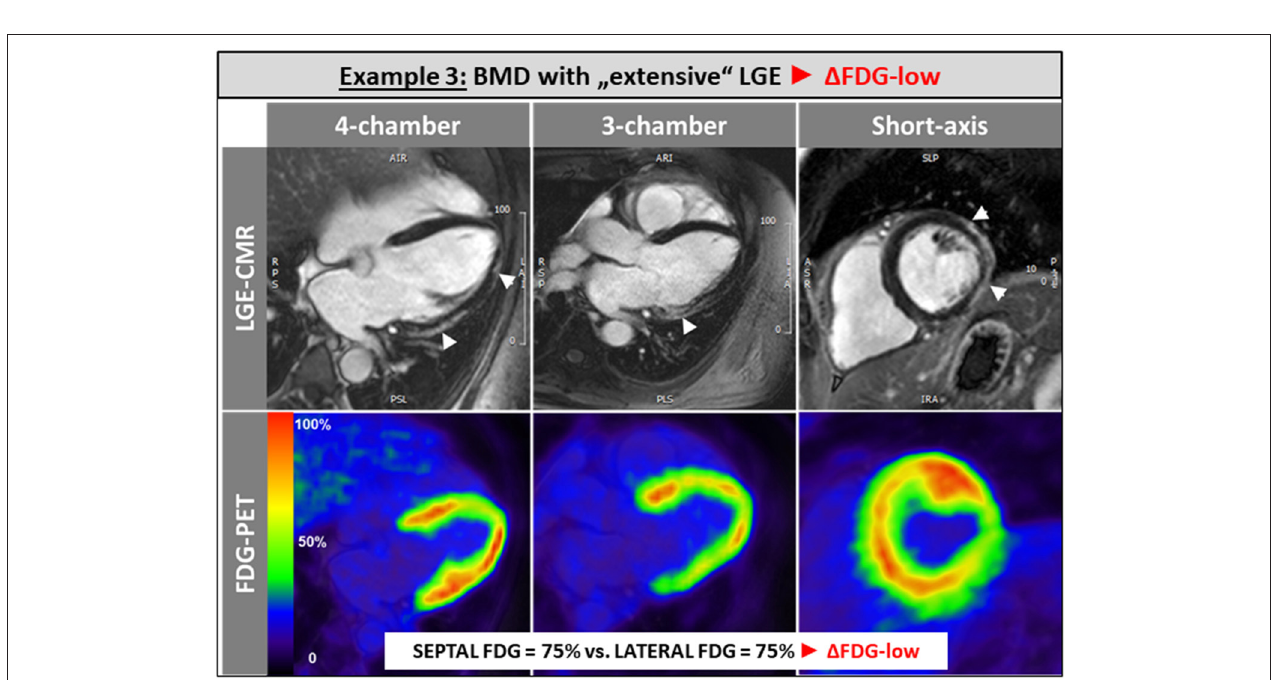
“relative” decrease in lateral wall FDG uptake due to a decreasing number of “viable” cardiomyocytes whilst growing scars in this